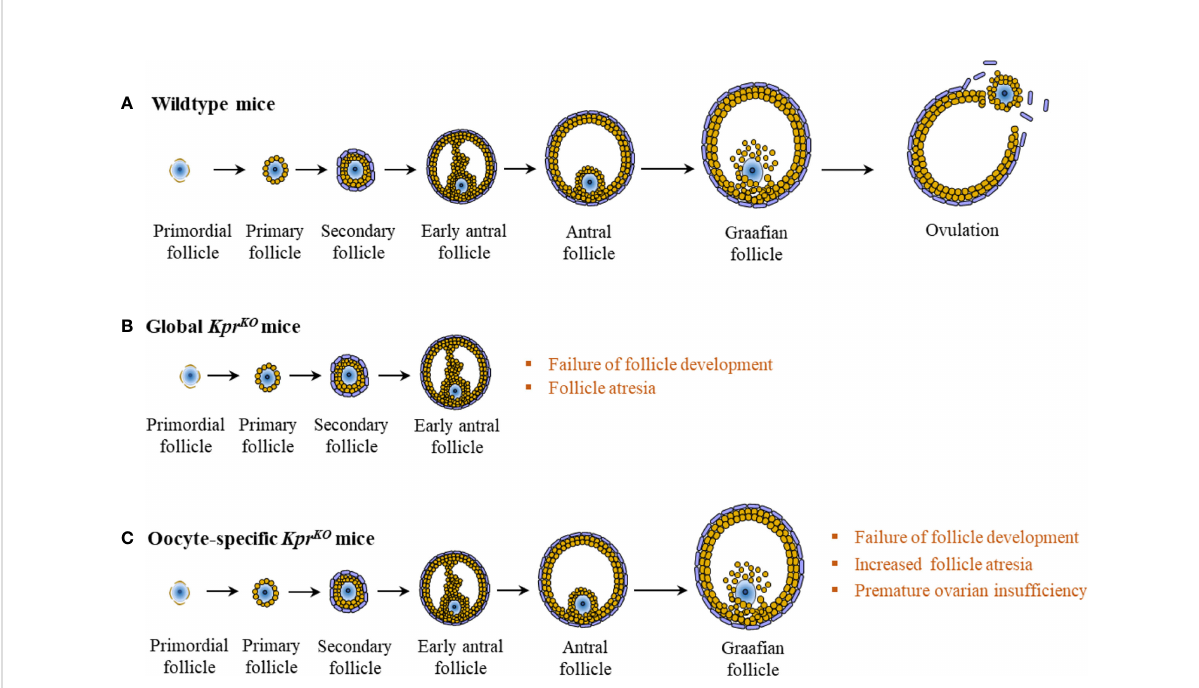
FIGURE 4 Intraovarian kisspeptin signaling. In wildtype mice, normal development of the ovarian follicle leads to ovulation (A) . However, in global Kpr KO mice, follicles fail to develop beyond the secondary or the early antral stage (B) . In contrast to wildtype or global Kpr KO mice, oocyte speci fi c Kpr KO mouse ovaries display markedly increased follicular atresia at late stages of follicle development, resulting in progressive failure of ovulation and premature ovarian insuf fi ciency at 4 to 6 months of age (C)